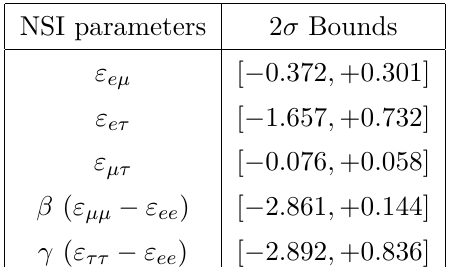
Table 1 . Bounds on the effective NC-NSI parameters from the neutrino oscillation experiments at 2 σ confidence level. Values of ε f in eq. (2.9) is taken from the global fit analysis [95]. αβ